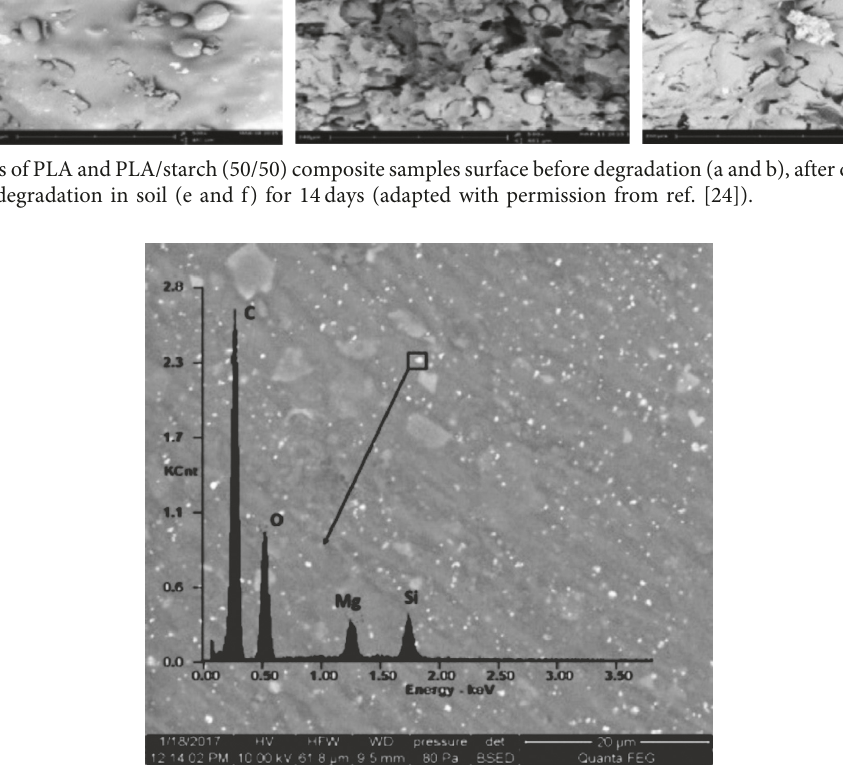
Figure 3: SEM-EDS micrograph of PLA/PBAT (40/60) blend surface at a magnification of 2500x (adapted with permission from ref.